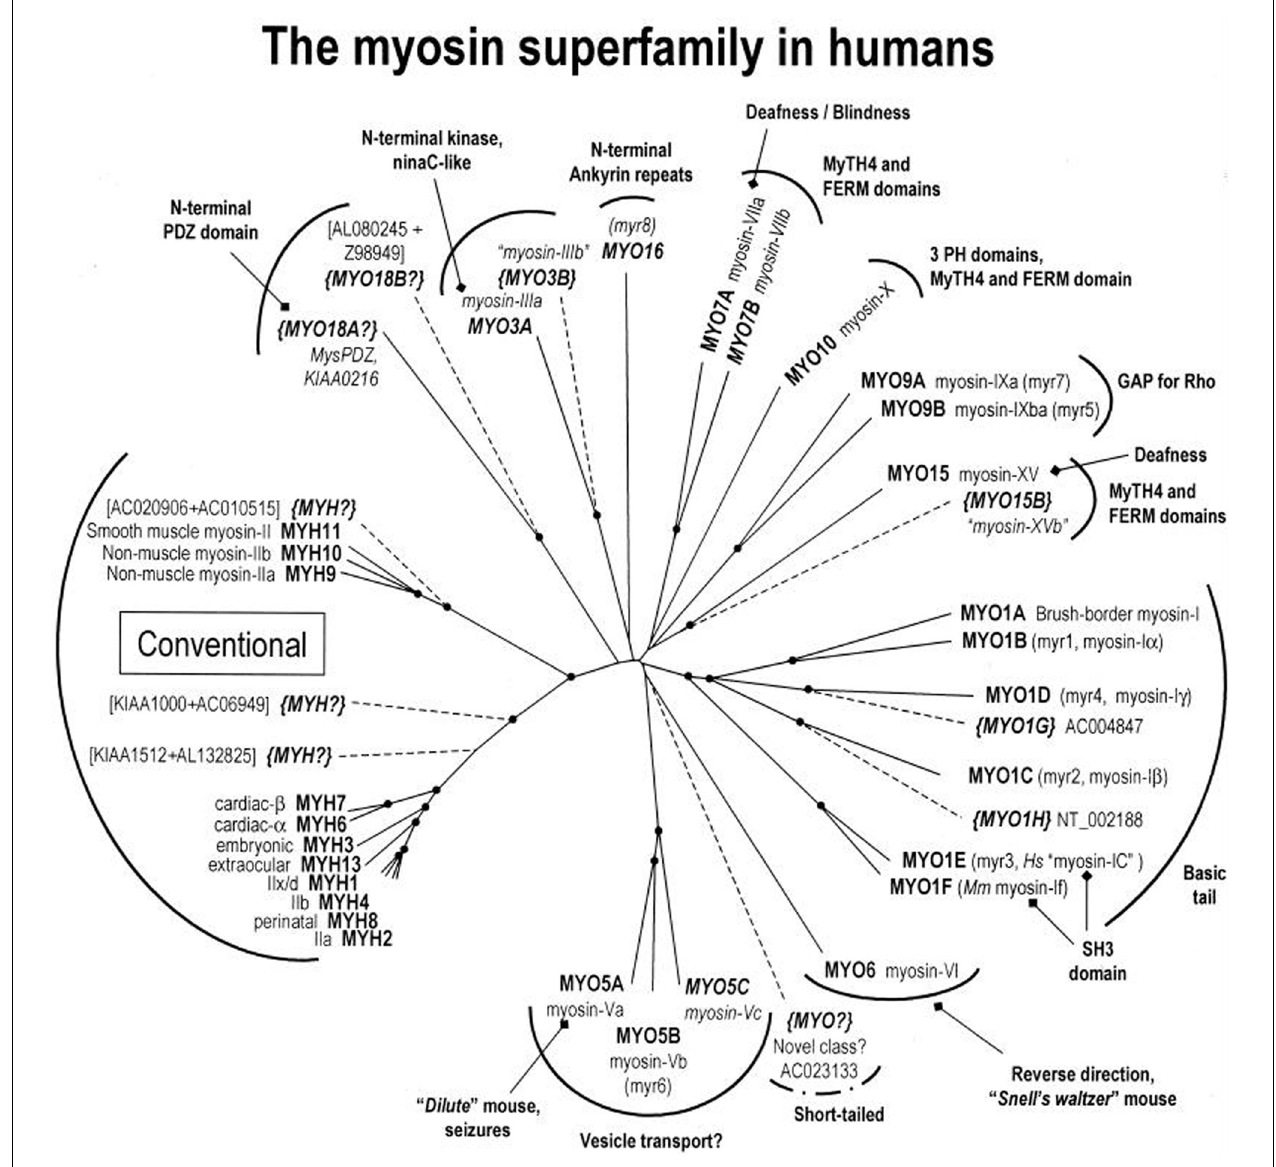
FIGURE 3 | A myosin phylogenetic tree of the human genome. Motor domain sequences from all myosins represented in the human genome were analyzed and grouped phylogentically and color coded as to class. Adapted from Berg et al. (2001).